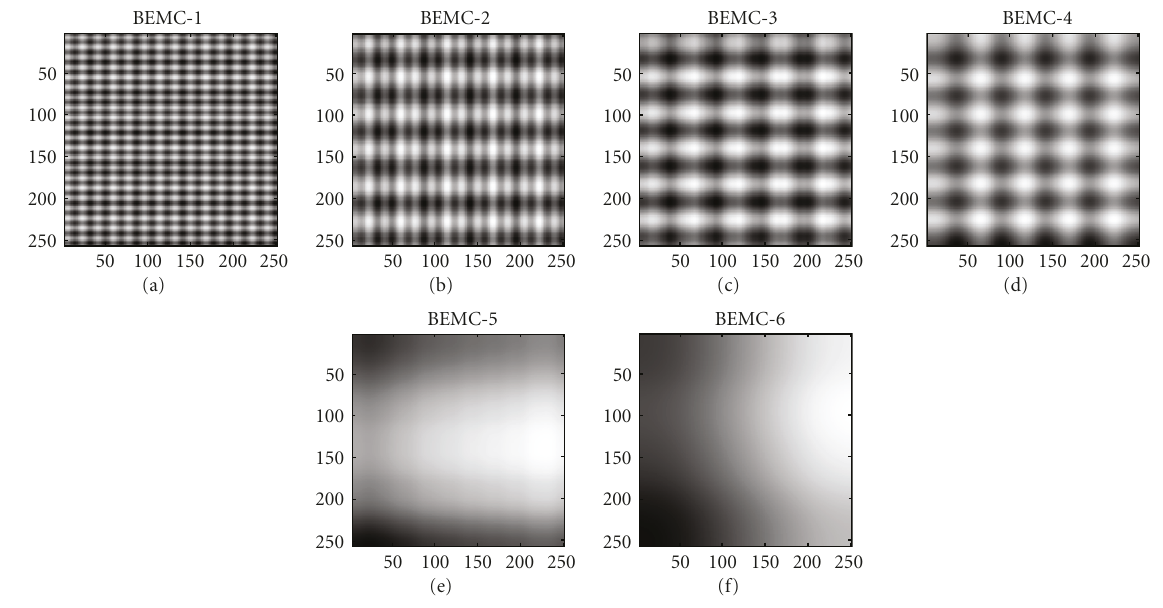
Figure 14: BEMCs of the STI obtained by FABEMD with Type-1 OSFW (MNAI = 1).